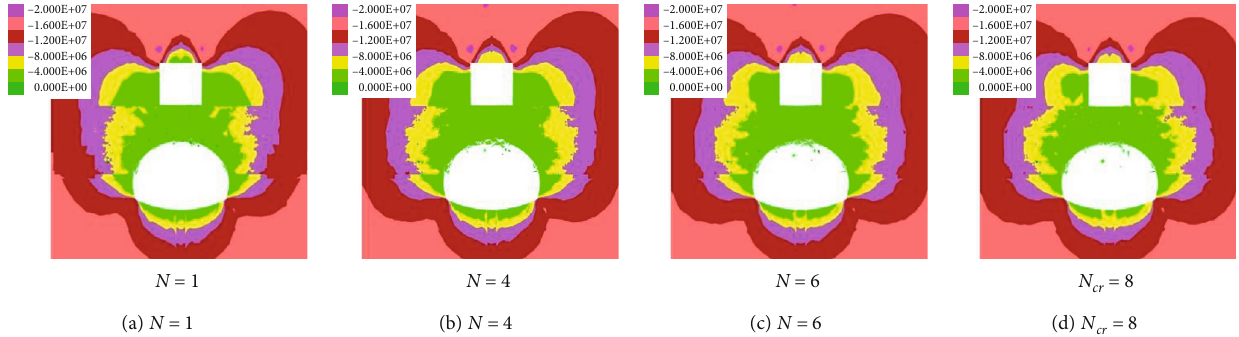
Figure 14: Evolution of minimum principal stress in the surrounding rock of the